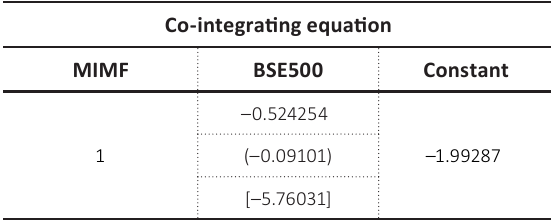
Table 7. Co-integrating vector of MIMF and BSE500